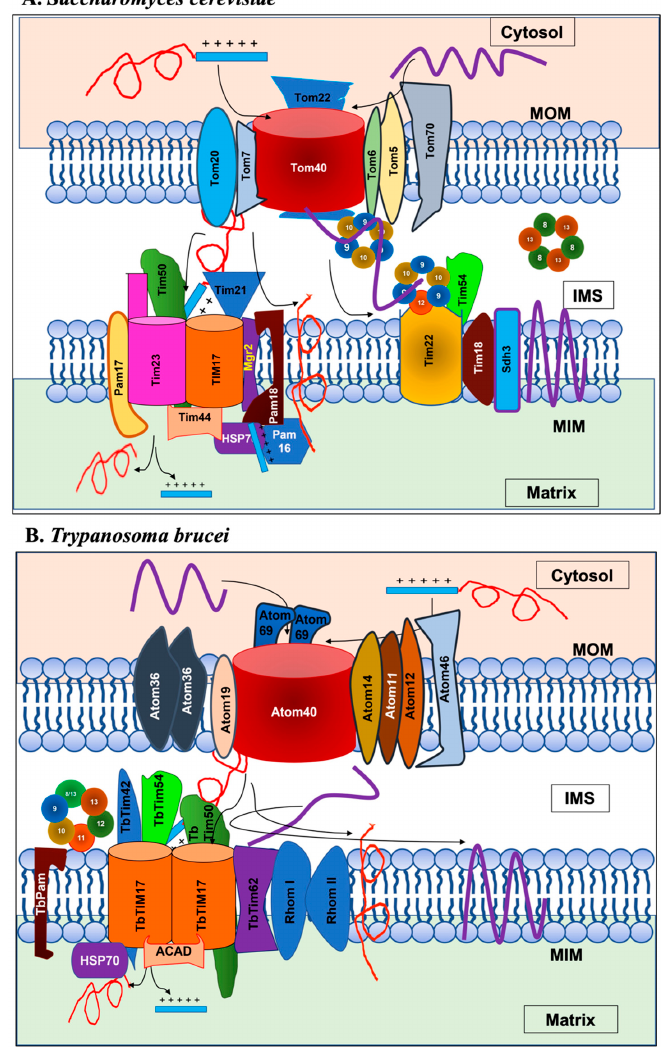
Figure 2. ( A ) Translocases of the mitochondrial outer and inner membranes, TOMs and TIMs, in Saccharomyces cerevisiae . The TOM complex consists of Tom40, Tom70, Tom20, Tom22, Tom5, Tom6, and Tom7. The two TIM complexes are TIM23 and TIM22. The core components of the TIM23 complex are Tim23, Tim17, and Tim50. Tim21 helps connect TIM23 with TOM and with respiratory complex III (not shown). Mgr2 couples Tim21 to the TIM23 core. TIM23 associates with the PAM complex consisting of Tim44, Hsp70, Pam16, Pam17, Pam18, and MgeI. The major component of the TIM22 complex is Tim22, and other components include Tim54, Tim12, Tim18, and Sdh3. The five small Tims are Tim8, Tim9, Tim10, Tim12, and Tim13. Tim9 and Tim10 as well as Tim8 and Tim13 form two separate heterohexameic complexes in the IMS to carry cargo proteins from the TOM complex to the TIM22 complex. ( B ) The ATOM complex and the single TIM complex in Trypanosoma brucei . The major component of the ATOM complex, Atom40, and other subunits Atom14, Atom11, Atom12, Atom19, Atom46, and Atom69 are shown. Atom36 often associates with Atom40 but is not a part of this complex. The major component of the TbTIM complex is TbTim17. TbTim62, TbTim42, Rhom I, and Rhom II are integral membrane proteins. TbTim50 is also membrane-integrated but possesses an IMS-exposed C-terminal domain. TbTim54 is a peripherally associated IMS protein. The location of ACAD is not known but expected to be in the matrix. Recent studies have shown TbPam27 as membrane bound. Small TbTims are associated with TbTim17. The cytosol, mitochondrial outer membrane (MOM), intermembrane space (IMS), mitochondrial inner membrane (MIM), and matrix are